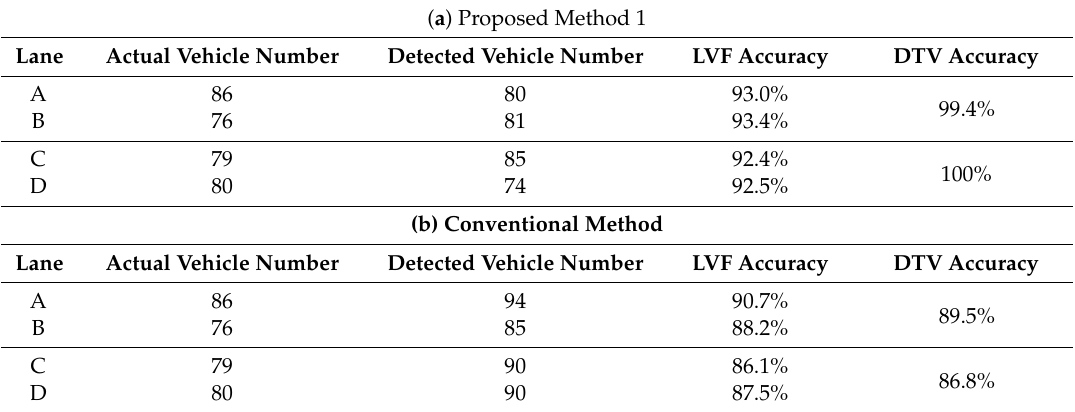
Table 5. Results of LVF and DTV detection during 8:50–9:00 AM (rush-hour traffic) using ( a ) proposed method 1 and ( b ) conventional method.